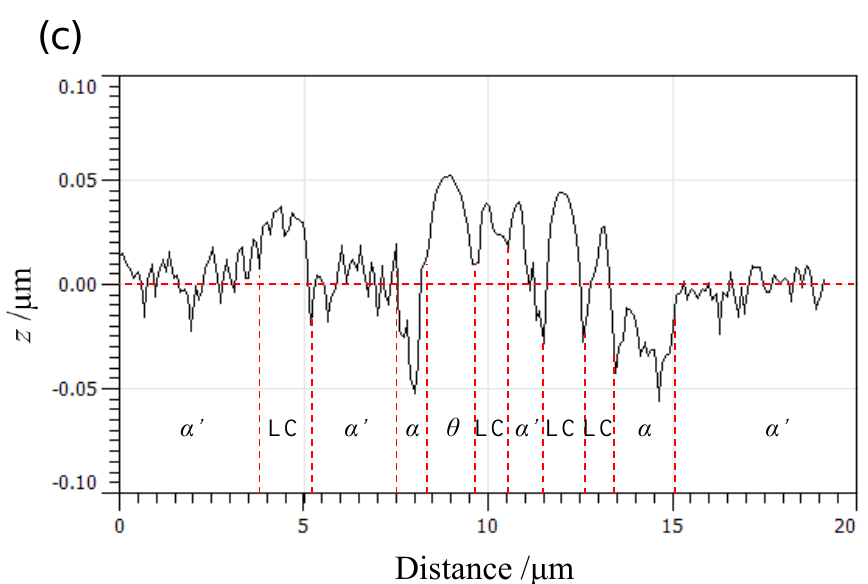
Figure 6. AFM characterisation on WEBs formed in the sample run to 2 × 10 9 cycles. ( a ) 2-dimensional AFM image of WEBs. ( b ) Topographic image of the WEBs shown in ( a ). ( c ) Height measurements of microstructural features along the arrowed line in ( a ).